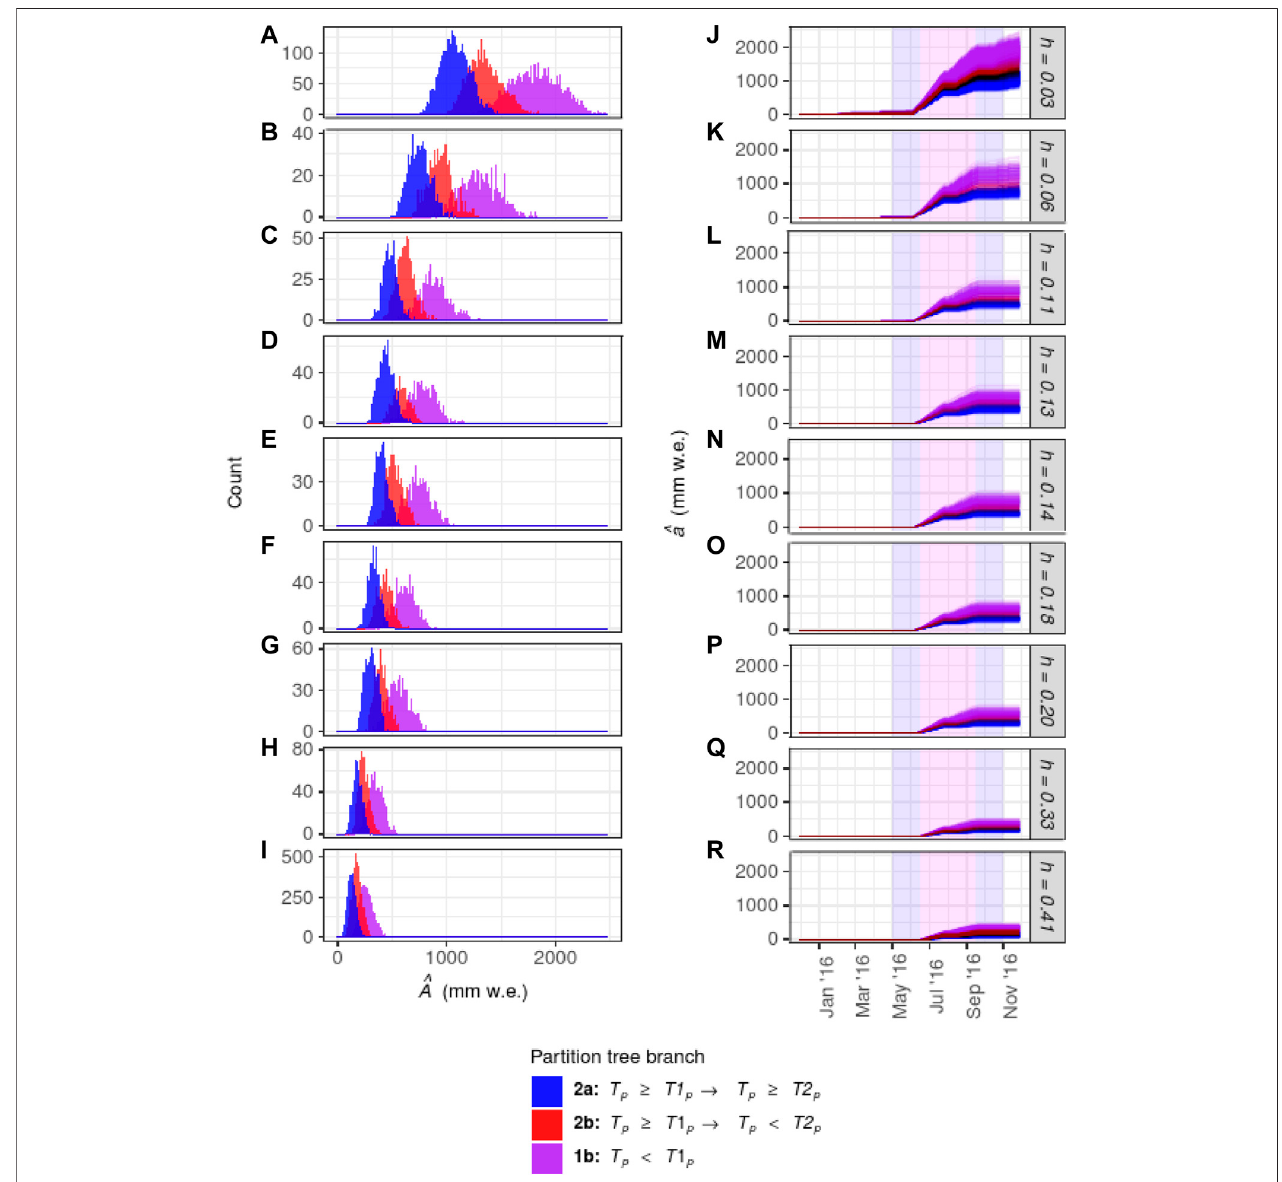
FIGURE 6 | Left column: Histograms of predicted annual ablation in 2016, ^ A , made in 10,000 ( h = 0.03 m and h = 0.41 m) and 2,000 ( h = 0.06 m to h = 0.33 m) Monte Carlo simulations. Right column: cumulative time series of daily ablation, ^ a , simulated in the Monte Carlo analysis. The data were subset using partition values calculatedinrecursivepartitionanalysis,representedbycolours.Thebackgroundcoloursinthesecondcolumnindicatetheseason,asde fi nedbyGovernmentofNepal (2021): white is winter, pink is monsoon, and blue is both pre- and post-monsoon.